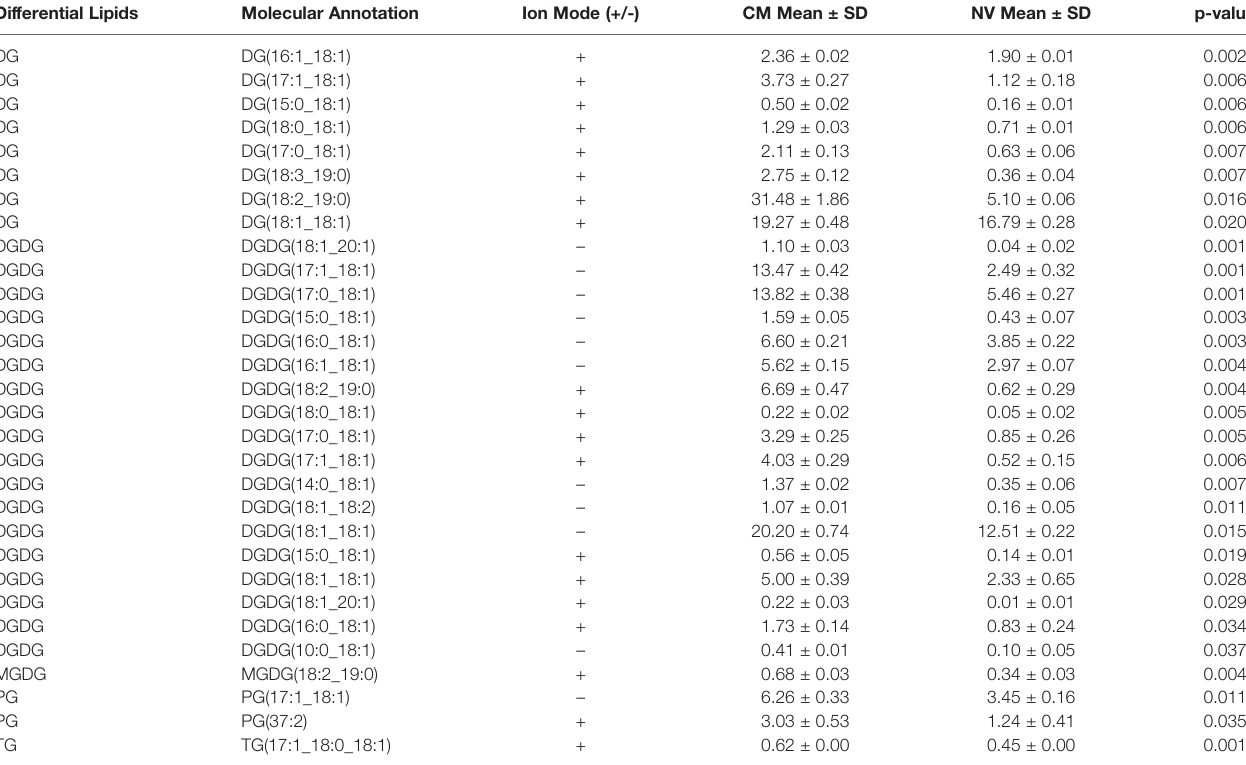
TABLE 3 | Lipids enriched in the CM of L. johnsonii N6.2. Differential Lipids